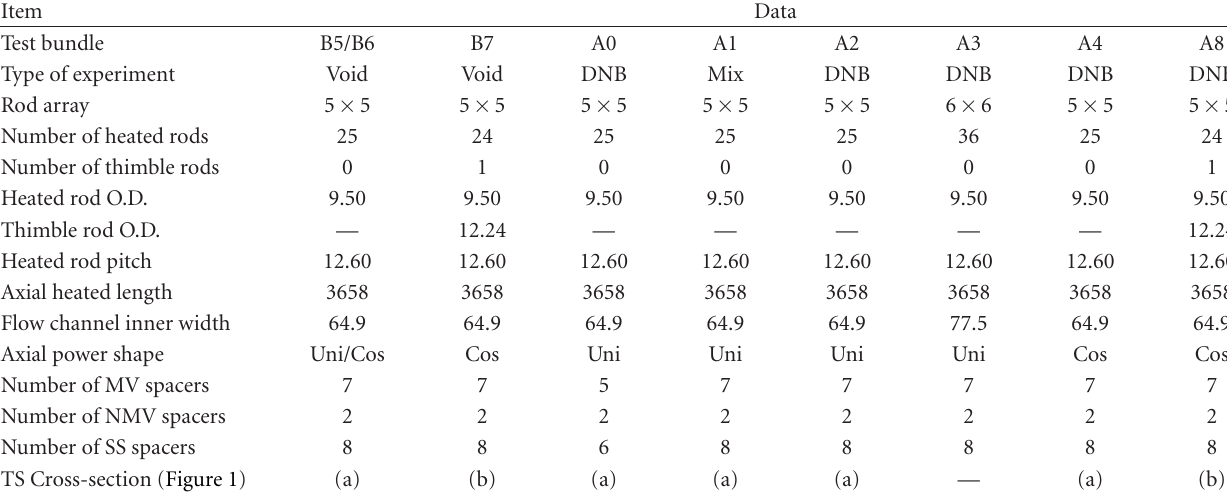
Table 2: Geometry of test bundles for PSBT benchmark